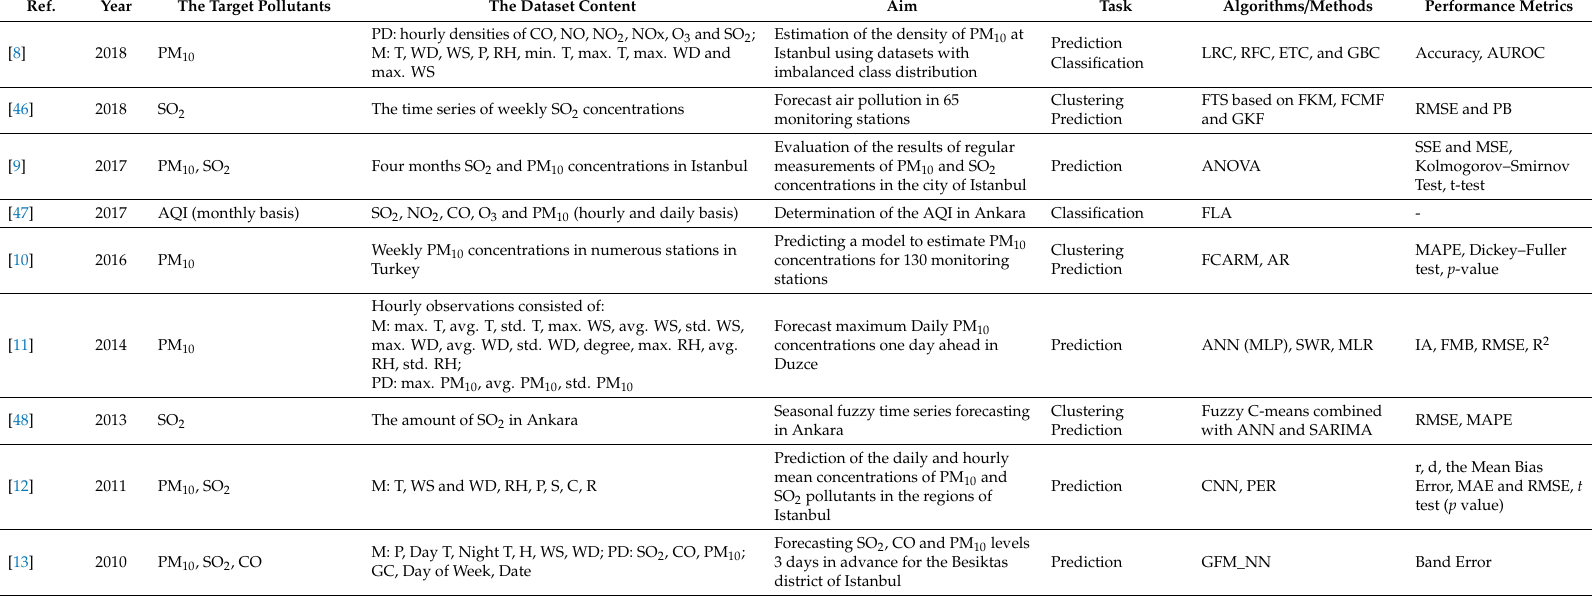
Table 1. Summary of the data mining studies with “air pollution in Turkey” as the main subject.